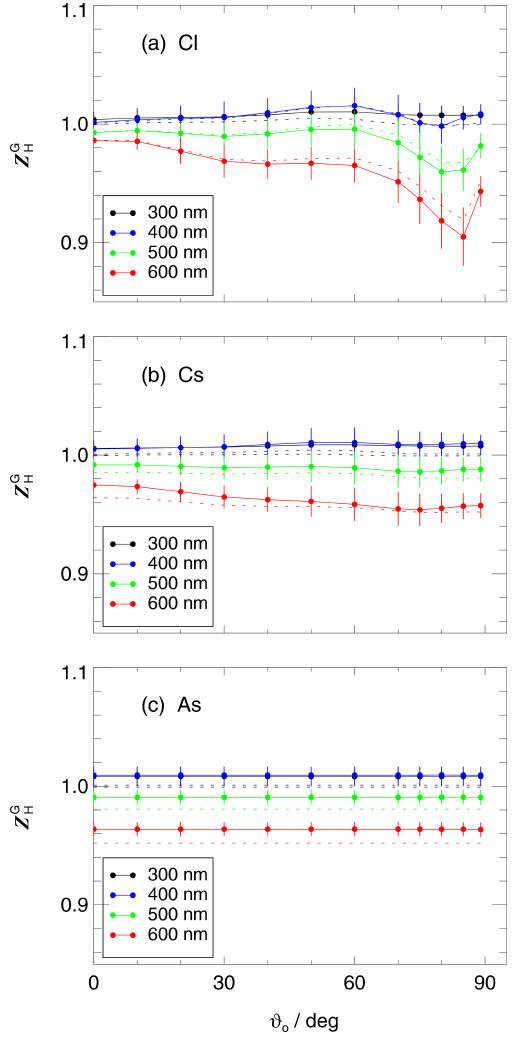
Figure 10. Modelled correction functions Z G for ground-based H measurements of downward spectral actinic flux densities with the HALO top receiver as a function of solar zenith angle for selected wavelengths. Corrections apply to a scenario with standard aerosol load and ground albedos at different cloud cases. (a) Clear-sky (Cl), (b) Cs cloud layer and (c) As cloud layer. Dashed lines show re- sults assuming isotropic distributions of downward diffuse spectral radiances for